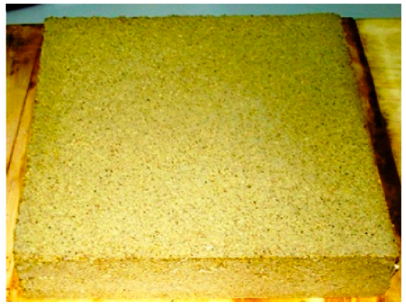
Figure 7. Lime–hemp mixture in insulation panels [42].